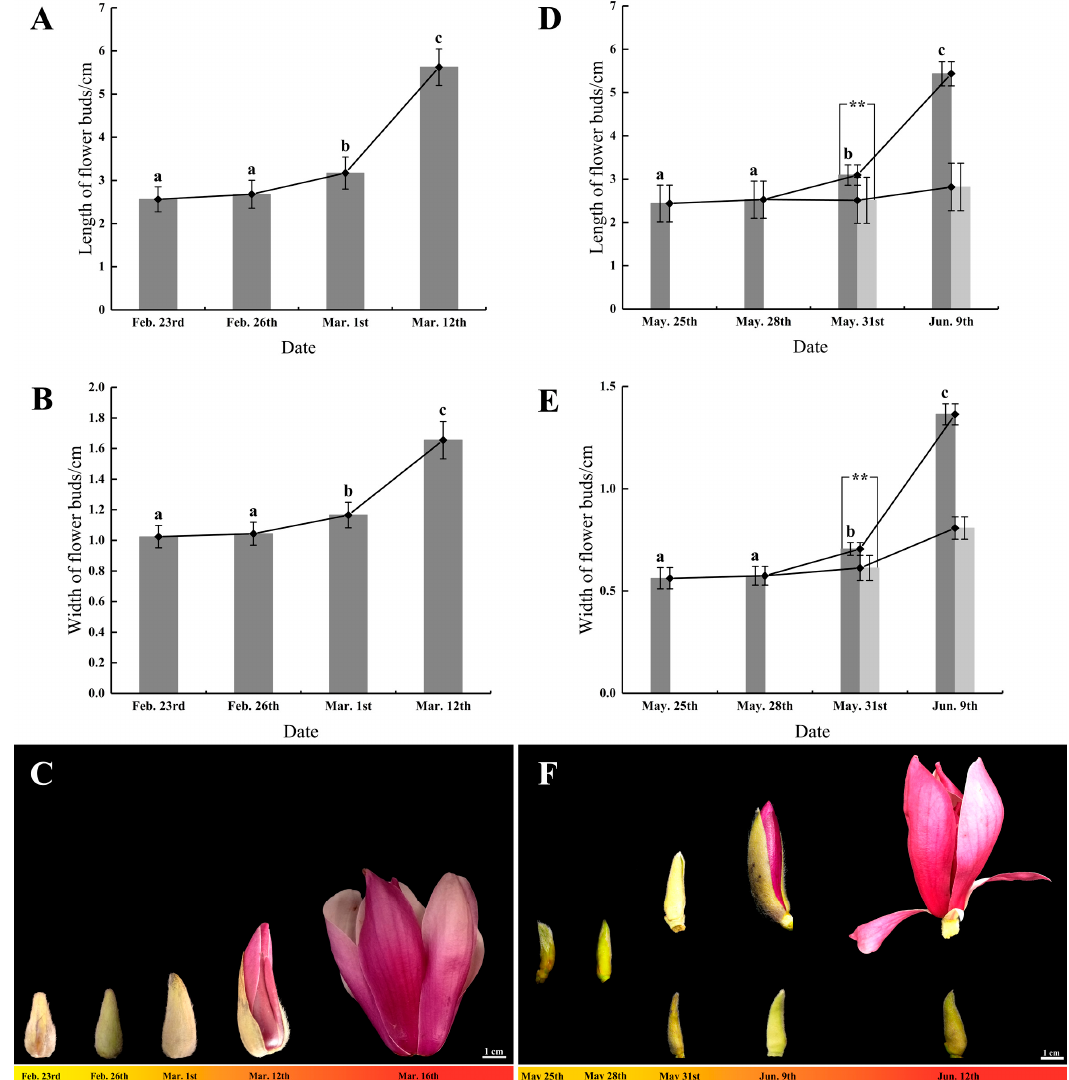
Figure 1. Morphological changes of flowering bud of ‘Changchun’. (A,D) The length growth of dormant, expanded, and red ‐ tepal ‐ exposed flower buds in spring flowering (A) and summer flowering (D) ; (B,E) the width growth of dormant, expanded, and red ‐ tepal ‐ exposed flower buds in spring (B) and summer (E) ; (C,F) the morphological changes of dormant, expanded, and red ‐ tepal ‐ exposed flower buds in spring (C) and summer (F) . ** represent that the significant difference reached extremely significant level ( p <